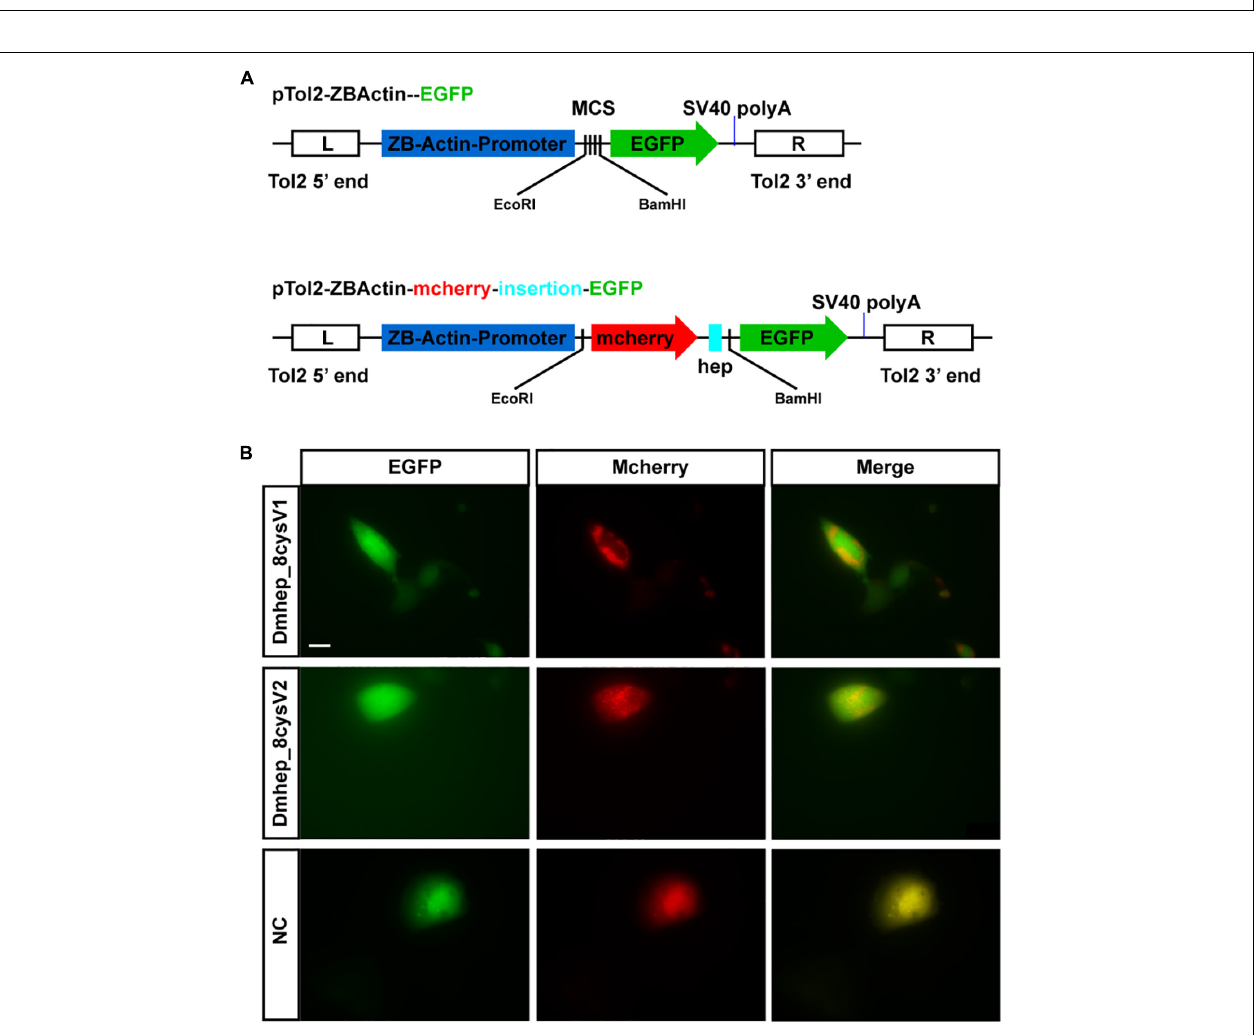
FIGURE 4 | Hepcidin prepropeptide were cleaved into mature peptide and propeptide in CHO cell line. (A) The structure of recombinant plasmid with or without CDS of hepcidin and fluorescent protein. (B) The distribution of red and green fluorescent protein in CHO cell line. NC, negative control.